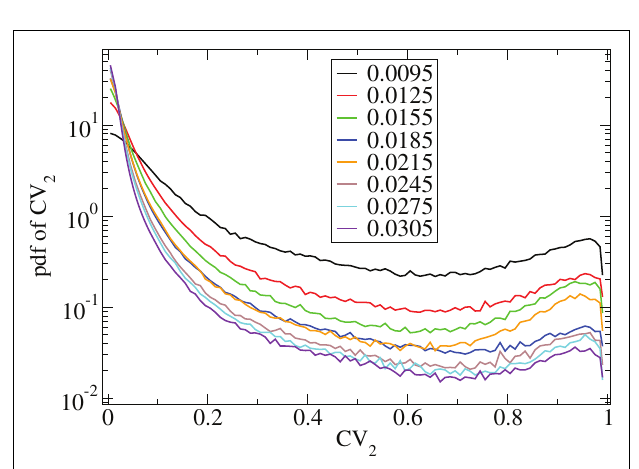
FIGURE 6 | CV 2 distributions for all cells combined for many network simulations in increasing input frequency steps of 0.003 spikes per msec (see key) corresponding to Figure 5.